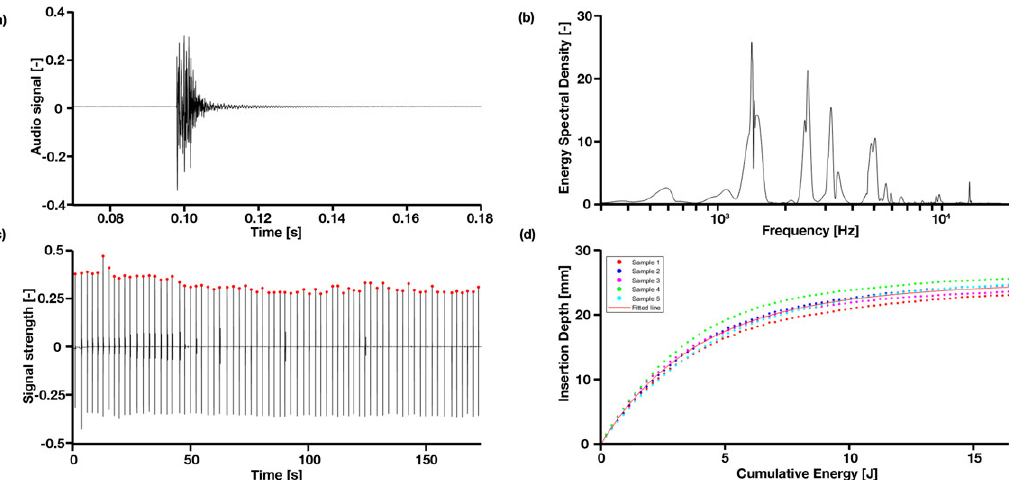
Figure 2. Typical hammer blow in time and frequency domain: ( a ) is the original audio signal; and ( b ) is the signal converted to ESD; ( c ) a complete set of hammer blows in signal intensity over time; ( d ) shows the cumulative energy over the insertion depth, caused by the hammer for the larger broach, well-fixated condition.